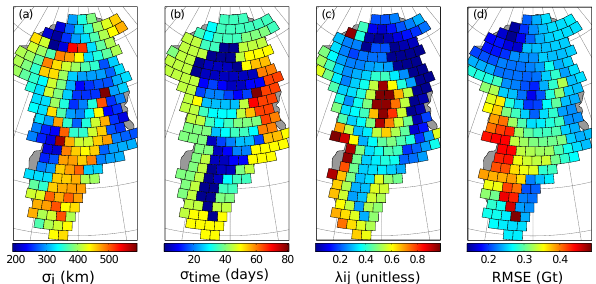
Figure 3. Optimal values of parameters used in spatial and tem- poral Gaussian filtering of MAR v3.5.2 and ISSM data: (a) the spatial Gaussian radius, (b) the temporal Gaussian radius, and (c) the leakage parameter. (d) RSME (Gt) for GRACE-LM-filtered vs. Gaussian-filtered MAR v2.0 (January 2003–December